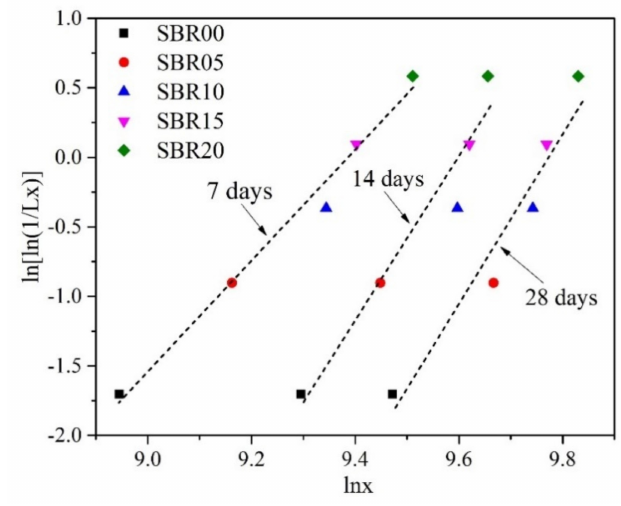
Figure 7. Weibull distribution of the energy absorption capacity (I). Table 4. Linear regression coefficients of energy absorption capacity of the Weibull